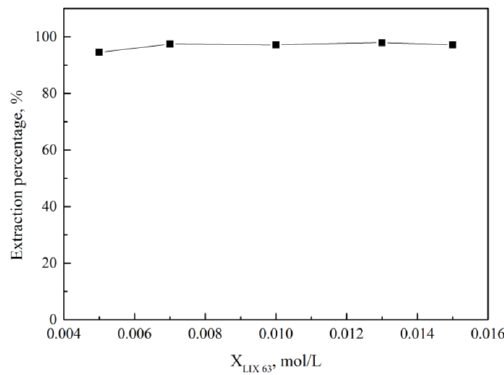
Figure 5. The effect of 5,8-diethyl-7-hydroxyldodecane-6-oxime (LIX 63) + Alamine 336 concentration on extraction of Pd(II). Aqueous: Pd = 100 mg/L, [HCl] = 5 mol/L. Organic: [LIX 63] + [Alamine 336] = 0.02 mol/L. O/A = 1. Diluent: kerosene. Table 9. Distribution ratio of Pd(II) by varying the concentration of 5,8-diethyl-7-hydroxyldodecane- 6-oxime (LIX 63) and Alamine 336.